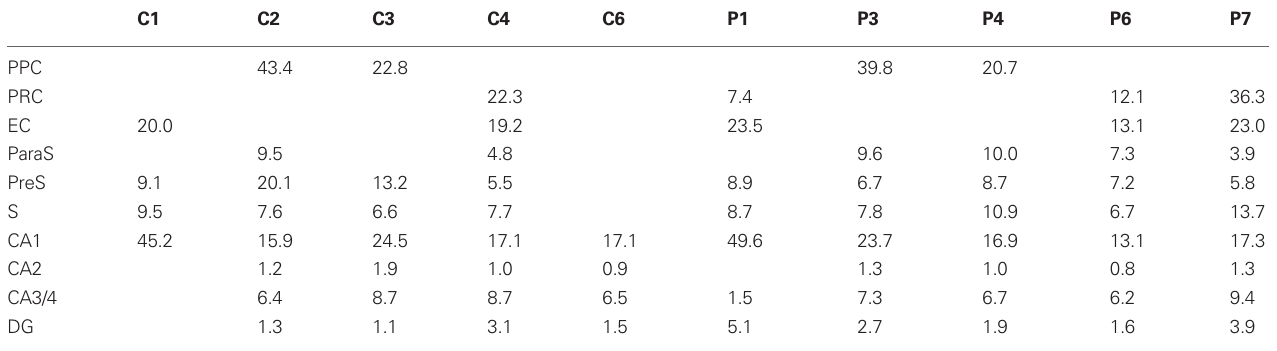
Table 3 | Total areas (mm 2 ) analyzed in control and AD